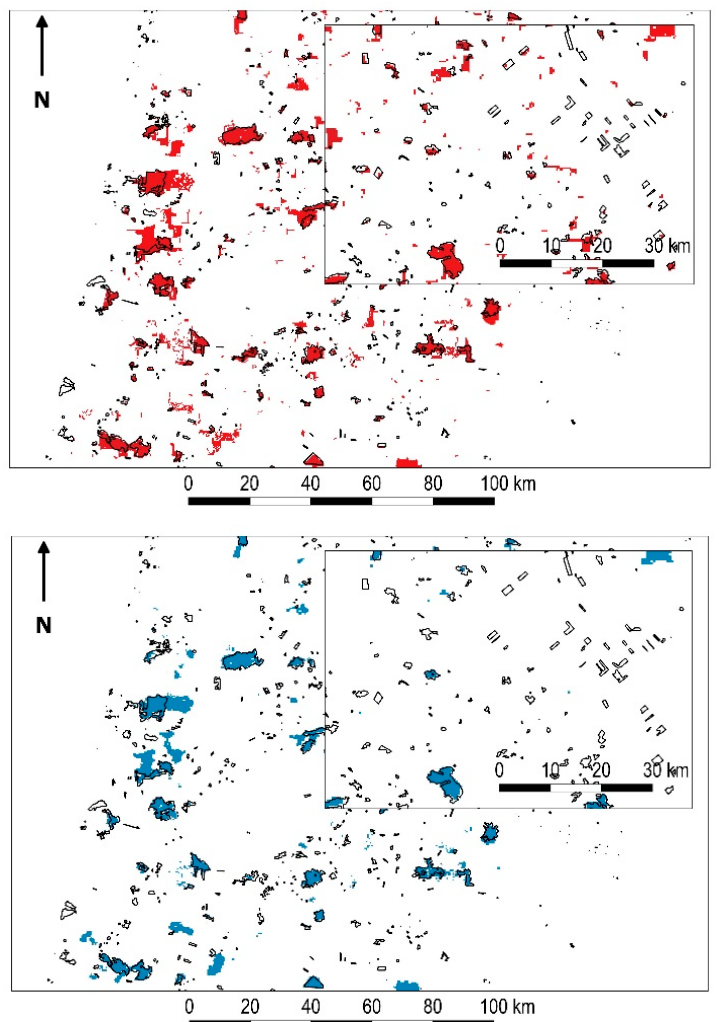
Figure 7. Burned area maps for Área Queimada —Project for On-Board Autonomy-Vegetation burned area product (AQM-PROBA) ( red ) and Moderate Resolution Imaging Spectroradiometer direct broadcast (DB) burned area product (MCD64A1) ( blue ) for 219/071 scene. The black outline represents the reference Landsat 8 fire scars perimeters. The small rectangles highlight examples of omissions cases related to small fire scars.